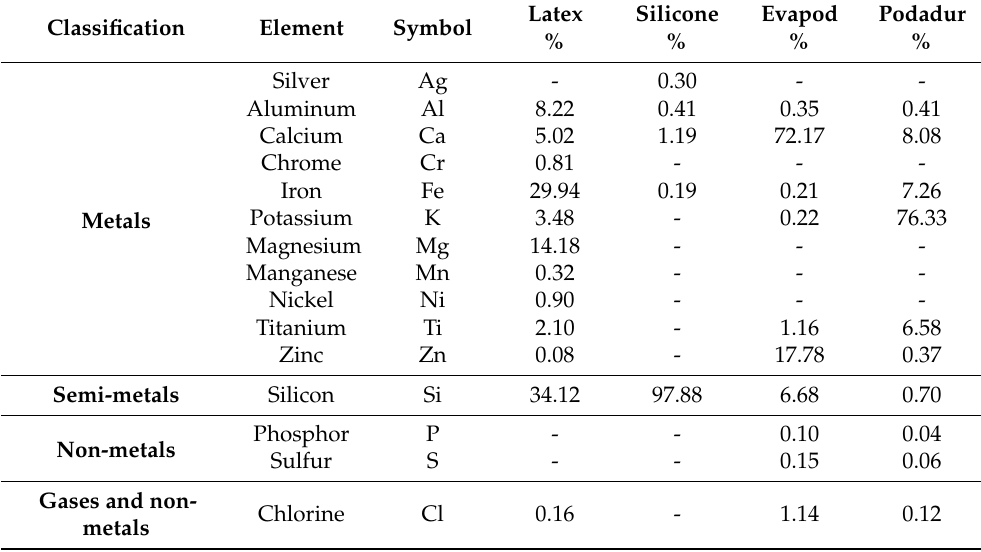
Table 3. Chemical composition of